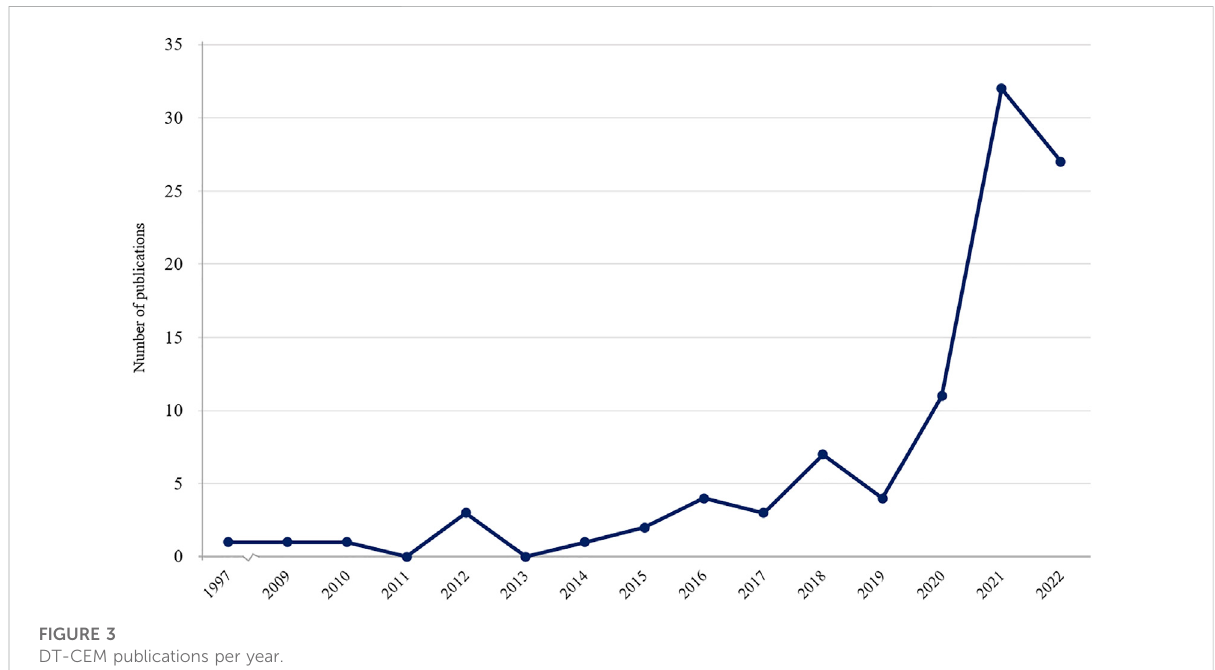
FIGURE 3 DT-CEM publications per